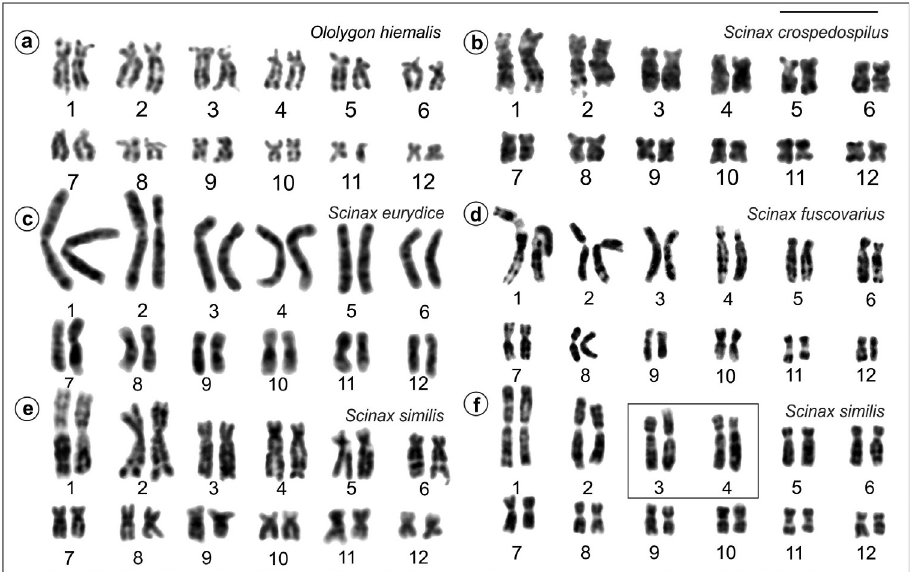
Figure 2. Replication banding in Ololygon and Scinax species. a O. hiemalis b S . crospedospilus c S . eurydice d S . fuscovarius e–f S. similis . Note heteromorphic chromosome pairs 3 and 4 in inset. Bar = 10